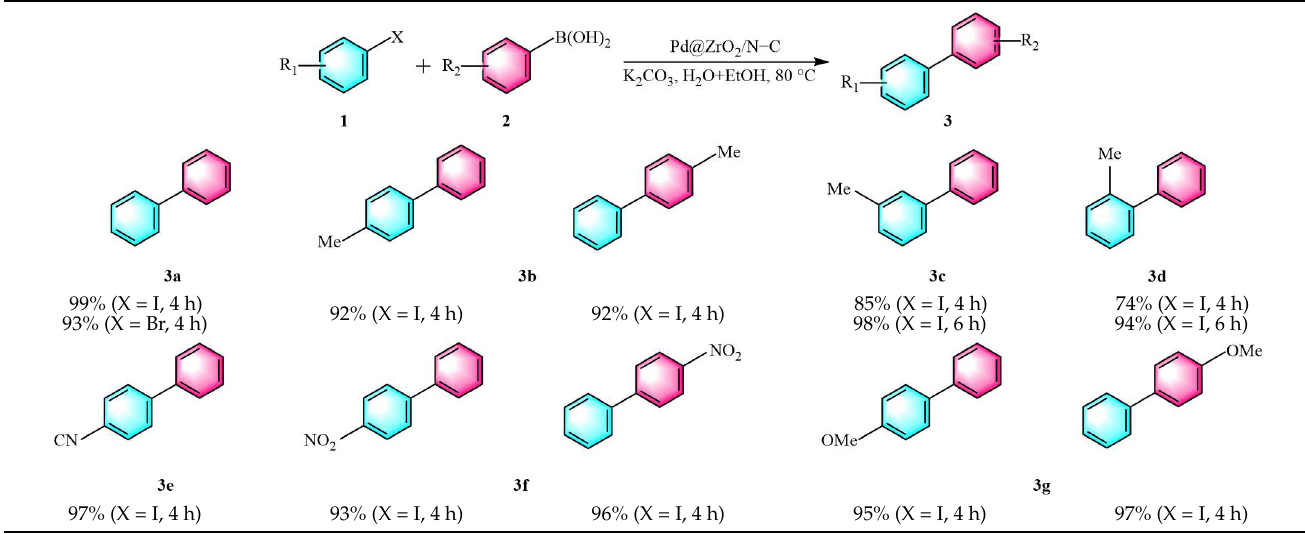
Table 2. Suzuki reactions of various substituted aryl halides and arylboronic acids a .